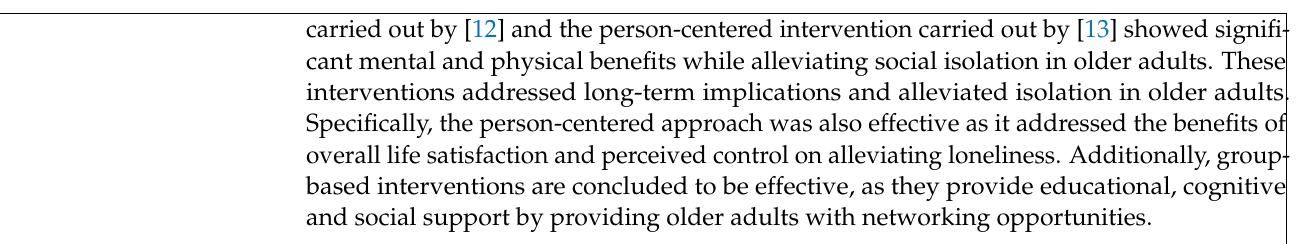
Table 1. Effectiveness and Implications of interventions against social